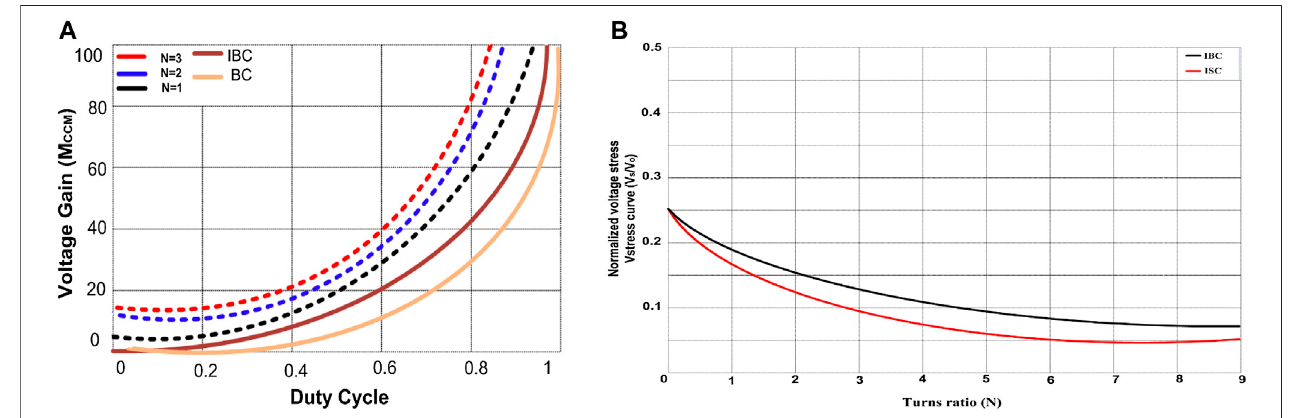
FIGURE 5 | (A) Duty cycle Vs Voltage gain with different turns ratio (B) Relationship between turns ratio and switch voltage